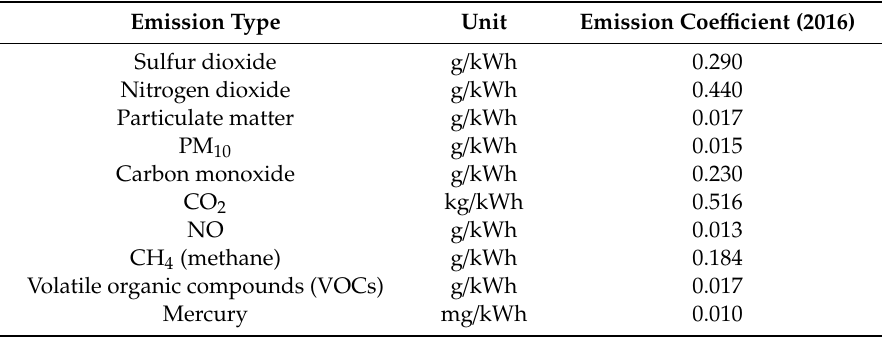
Table 4. Specific emission factors of energy